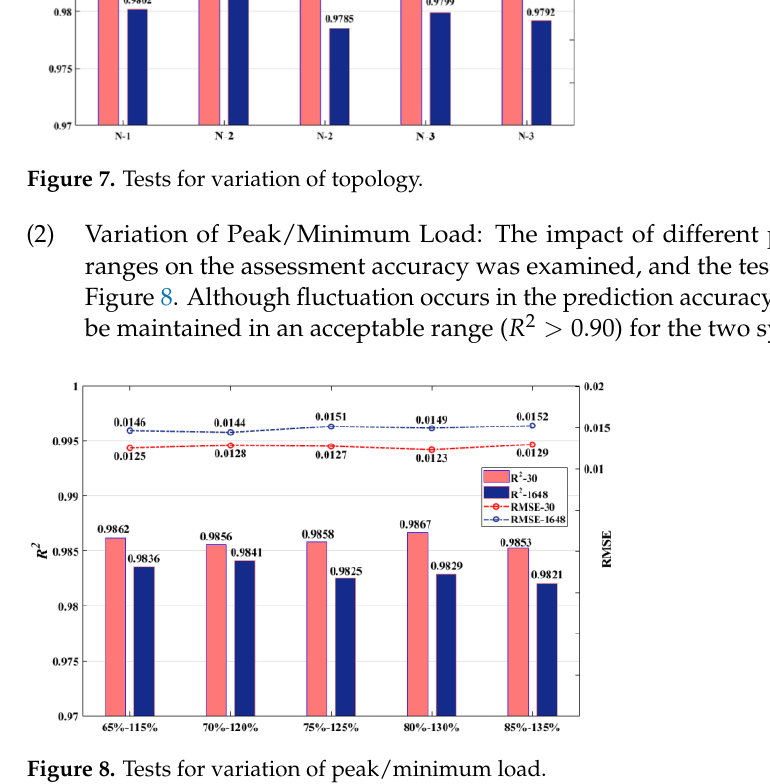
Figure 8. Tests for variation of peak/minimum load.